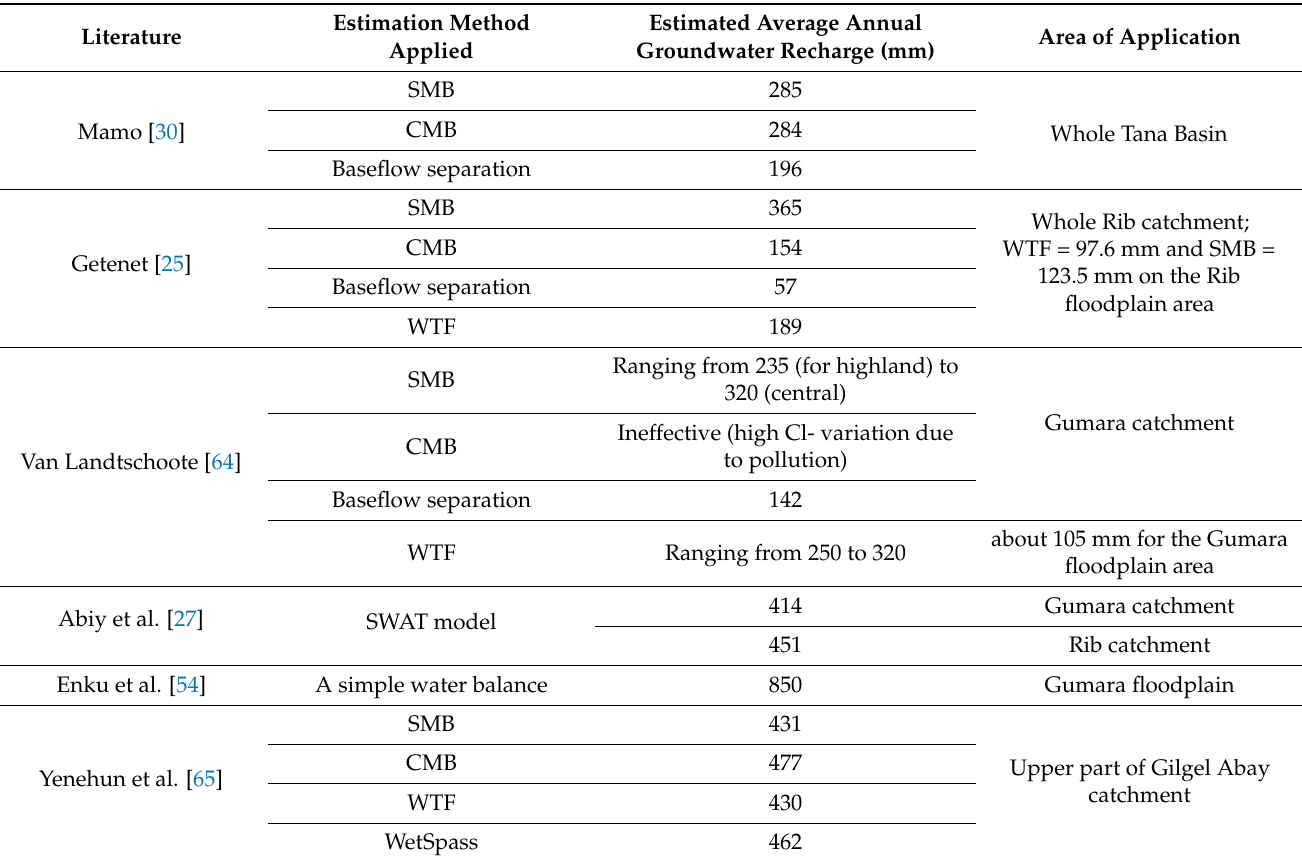
Table 5. Summarized groundwater recharge values estimated either on the whole Tana basin or on its catchments using different